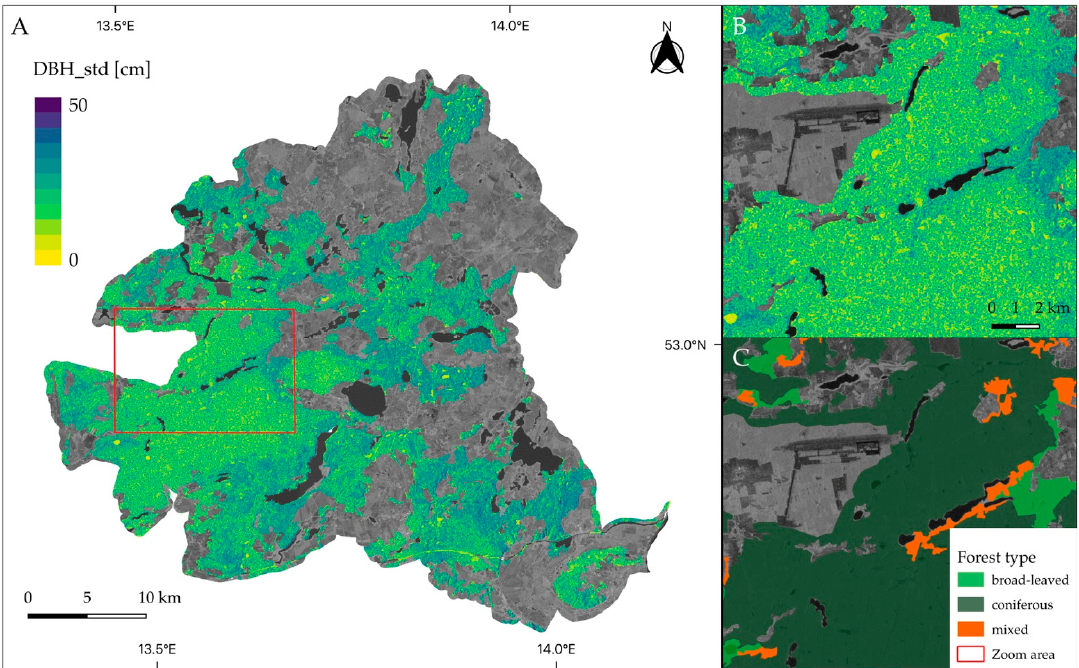
Figure 10. Map of predicted standard deviation of tree diameter (DBH_std) for Schorfheide-Chorin ( A ). A closer look on the predictions is given in ( B ) whereas ( C ) provides a comparison with forest types. Predictions were masked according to the forested areas of CLC 2018 dataset. A VH-scene